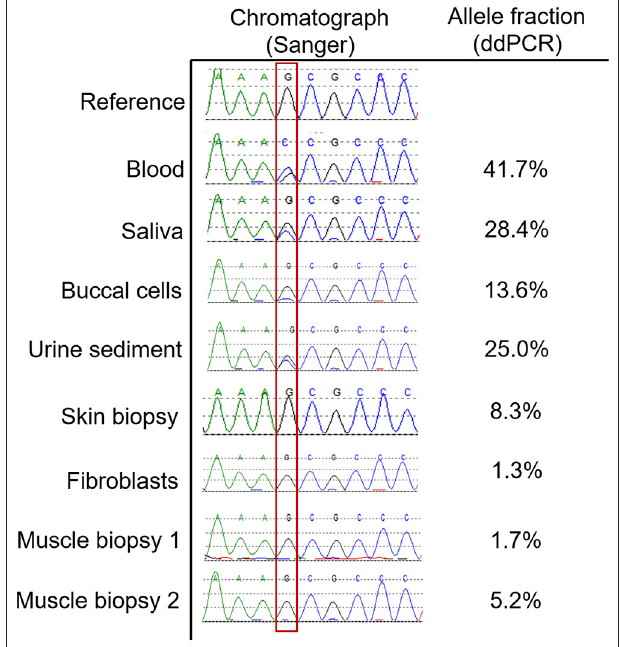
FIGURE 2 | Allele fractions of the DMD variant in various tissue types. This figure shows the Sanger sequencing chromatographs at the position of the DMD variant (outlined with red box) in various tissue types, which is quantified using the described allele specific ddPCR assay. Blood predictably demonstrated an allele fraction that was approaching 50%. For tissue types that do not contain significant numbers of white blood cells, such as skin, fibroblasts, and muscle, the allele fractions were below 10%. For other tissues that contain a high proportion of white blood cells such as saliva, urine sediment and buccal cells, the allele fractions were